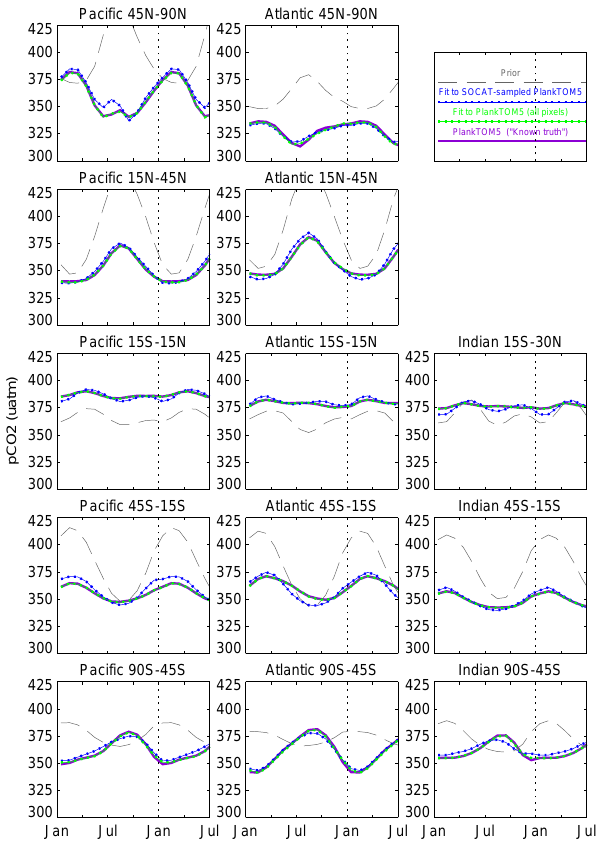
Fig. 13. Top: Map of a-priori correlation coefficients with respect Fig. B1. Testing the capacity to retrieve the p CO 2 field from the to an example pixel at (70 ◦ E,49 ◦ S), illustrating how inverse adjust- SOCAT data set: fit of the diagnostic scheme to the p CO 2 field sim- ments to f DIC int de-correlate with distance. Bottom: A-priori correla- Fig. 14. Testing the capacity to retrieve the p CO 2 field from the ulated by the PlankTOM5 biogeochemical model (Buitenhuis et al., tion coefficients with respect to an example time step in the middle SOCAT data set: Fit of the diagnostic scheme to the p CO 2 field 2010) (combined with seasonality from Takahashi et al. (2009)) of the inversion period; in addition to the de-correlation away from simulated by the PlankTOM5 biogeochemical model (Buitenhuis sub-sampled at locations/times of the SOCAT measurements (blue), the example time step, correlations rise again each year due to the et al., 2010) (combined with Takahashi et al. (2009)’s seasonality) dominance of the seasonal cycle. compared to the simulated p CO 2 field itself (“known truth”, violet). sub-sampled at locations/times of the SOCAT measurements (blue), For further comparison, a fit of the scheme to the simulation at ev- compared to the simulated p CO 2 field itself (“known truth”, violet). ery grid cell and time step (“complete information”, green) and the For further comparison, a fit of the scheme to the simulation at ev- Bayesian prior (“no data information”, thin dashed grey, partially ery grid cell and time step (“complete information”, green) and the off-scale) is given. The p CO 2 fields have been averaged over the Bayesian prior (“no data information”, thin dashed gray, partially regions as in Fig. off-scale) is given. The p CO 2 fields have been averaged over the regions as in Figure 7.